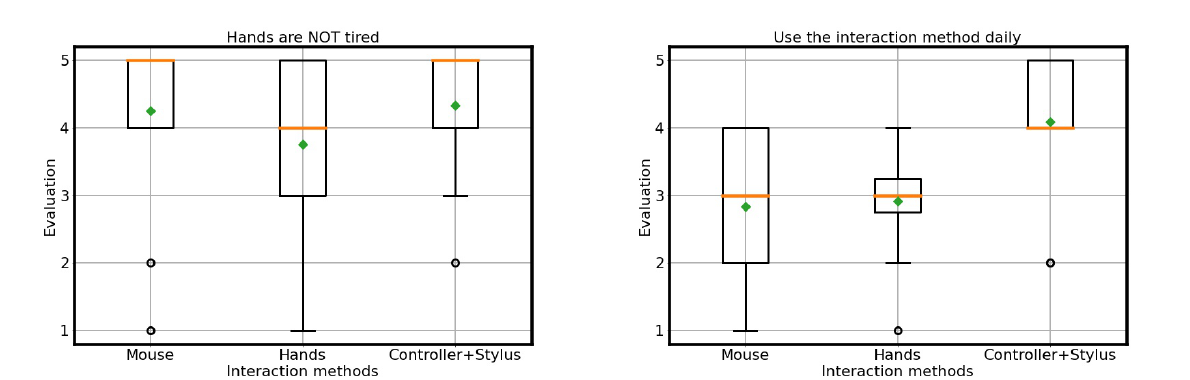
Figure 5. Box plot visualizations of the fatigue and daily use evaluations. The evaluation of fatigue ( left ): none of the methods were found to be particularly tiring. The evaluation of possible daily use ( right ): controller+stylus was significantly more usable for daily use than the other